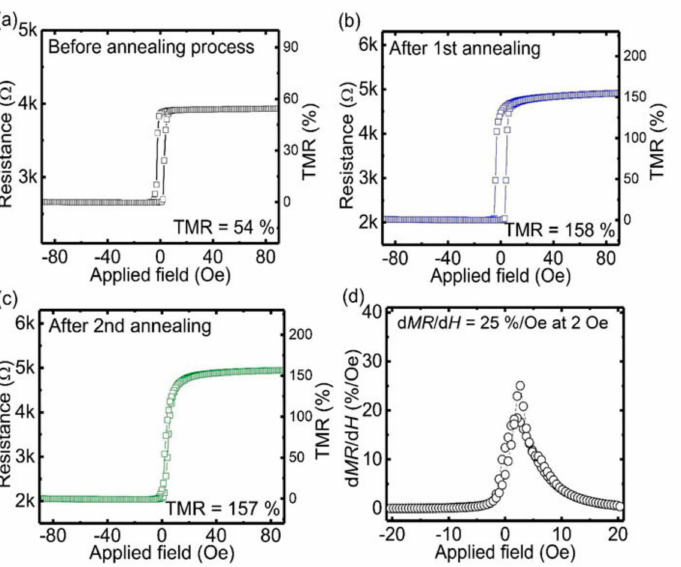
Figure 17. The transfer curves of the TMR sensor proposed in [141] ( a ) before the annealing process, ( b ) after the first annealing, with an applied magnetic field of 10 kOe at 350 ◦ C, ( c ) after the second annealing process, with an applied magnetic field of 10 kOe at 300 ◦ C, and ( d ) the dMR/dH depen- dence on the applied magnetic field are plotted. Reprinted with permission from Z. Jin et al., 2021 AIP Advances 11(1) [141], under a Creative Commons Attribution (CC BY) license. Copyright 2021 AIP